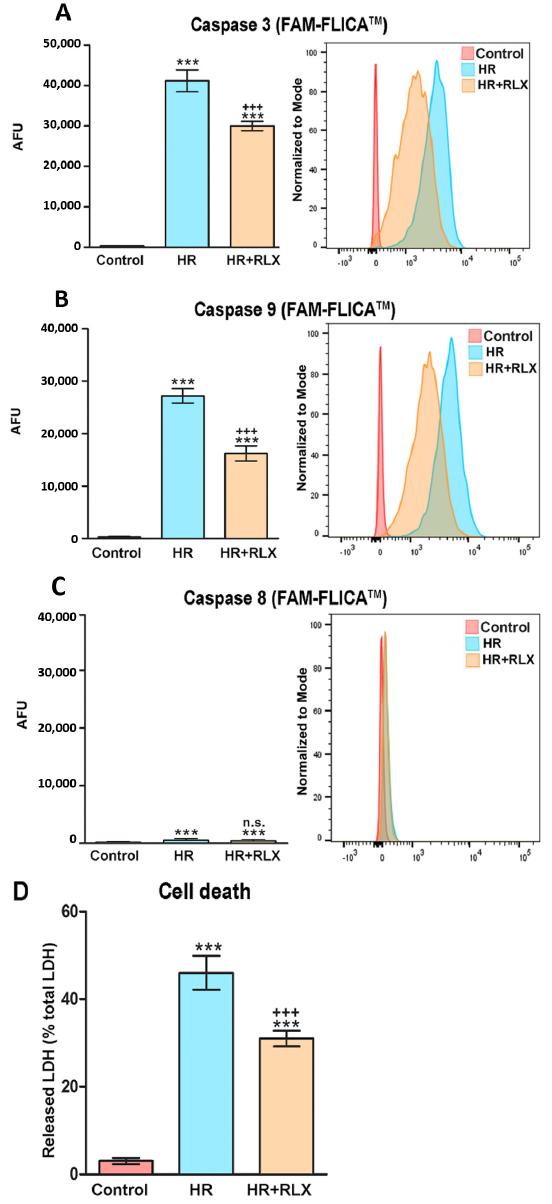
Figure 4. Quantitative evaluation and representative FACS diagrams of cellular apoptosis assayed by fluorescent probes. The activity of caspase 3 ( A ) and 9 ( B ), which are involved in the extrinsic apoptotic pathway, are markedly increased upon hypoxia–reoxygenation (HR), an e ff ect prevented by RLX (17 nmol L − 1 ) added before hypoxia and at reoxygenation. On the other hand, caspase 8 ( C ), which is involved in the intrinsic apoptotic pathway, is slightly (albeit significantly) increased by HR, but not substantially a ff ected by RLX. Overall cell death ( D ), evaluated by LDH release, was also markedly increased by HR, and reduced by RLX. (AFU: arbitrary fluorescent units). Significance of di ff erences ( n = 3): *** p < 0.001 vs. controls, +++ p < 0.001 vs. HR, n.s. not significant vs.